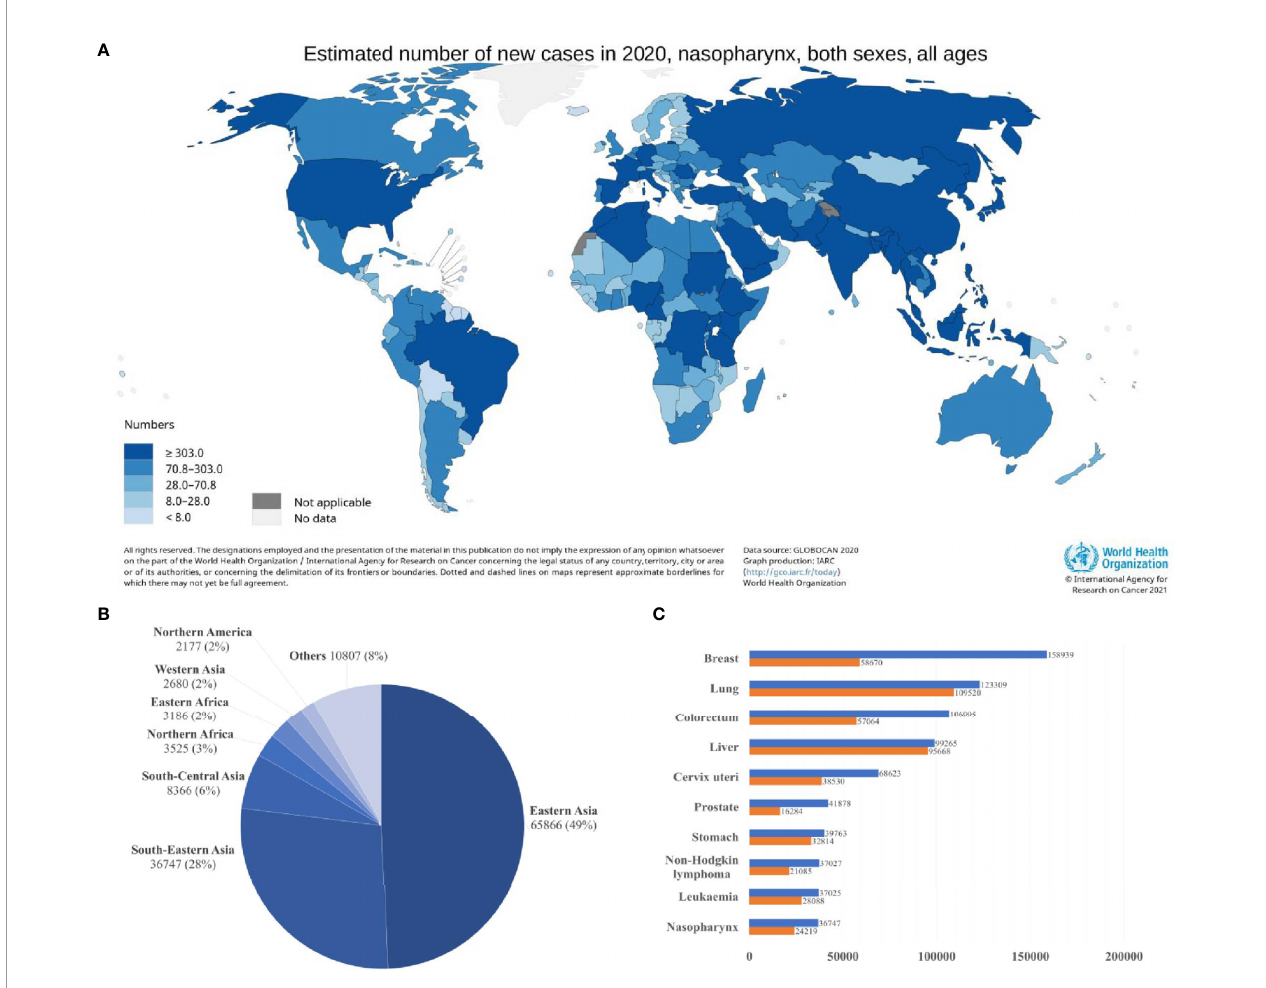
FIGURE 1 | Global distribution of nasopharyngeal carcinoma (A) Estimated age-standardized incidence rate (ASR; world) (B) Estimated number of new cases in different world areas. (C) Estimated number of incident cases and deaths in South-Eastern Asia. Data source: GLOBOCAN 2020